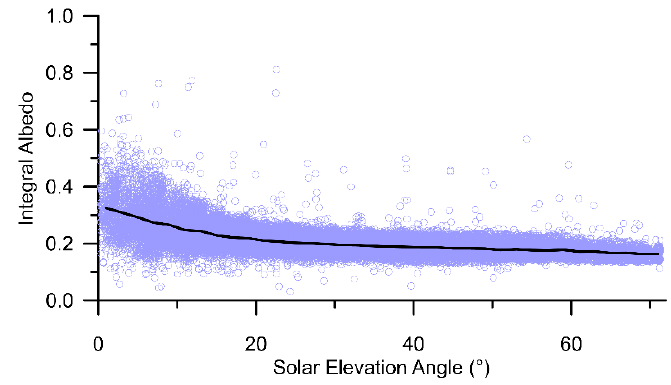
Figure 2. Integral Albedo for TVGr.